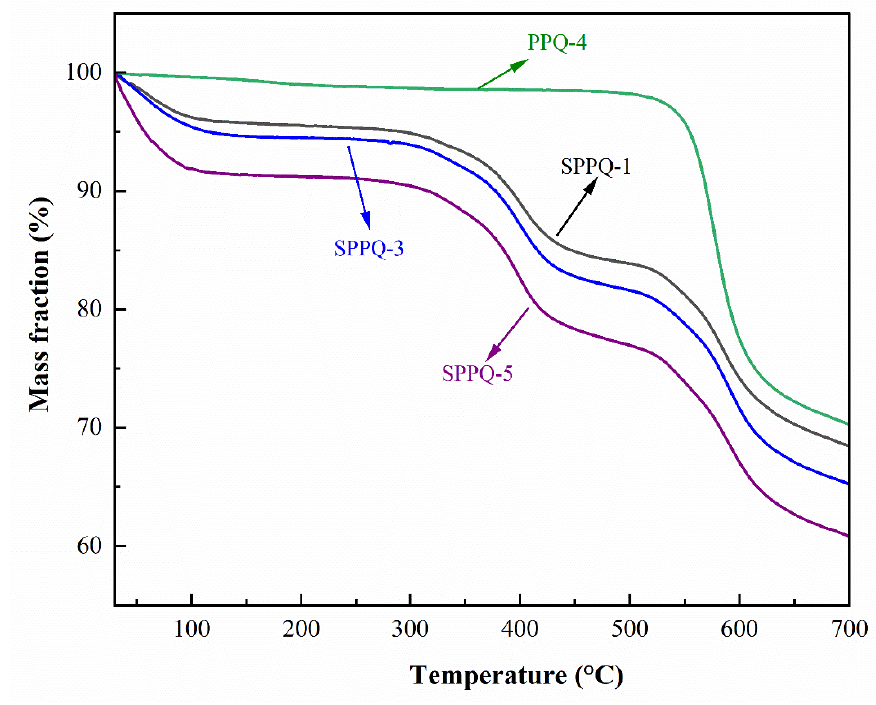
Figure 7. TGA curves of PPQ and SPPQs.